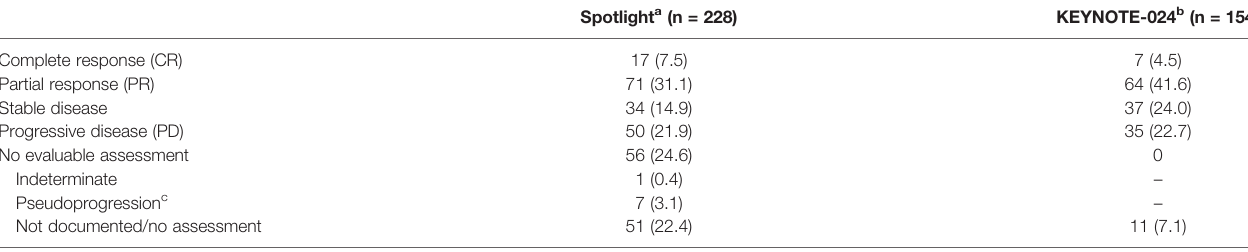
TABLE 3 | Best real-world tumor response (rwTR) to fi rst-line pembrolizumab monotherapy: Spotlight cohort.